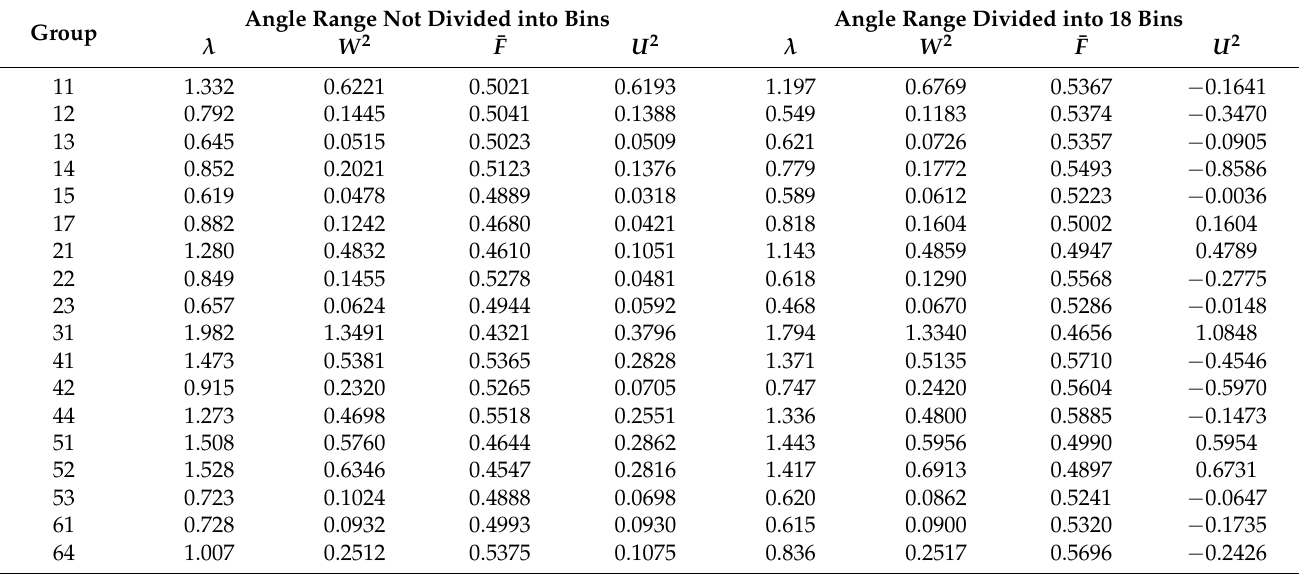
Table A1. Comparison of statistical tests calculated by dividing and not dividing the range of the analyzed angle δ D into bins, with the inclination taken directly from the NBG